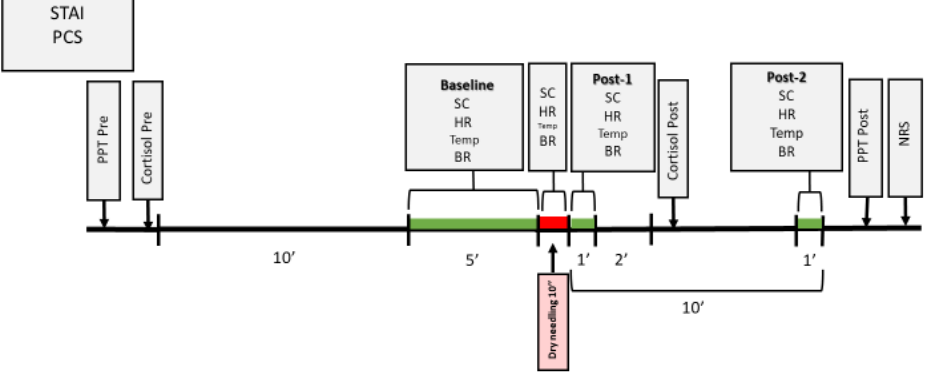
Figure 3. Temporal chronogram of the study.